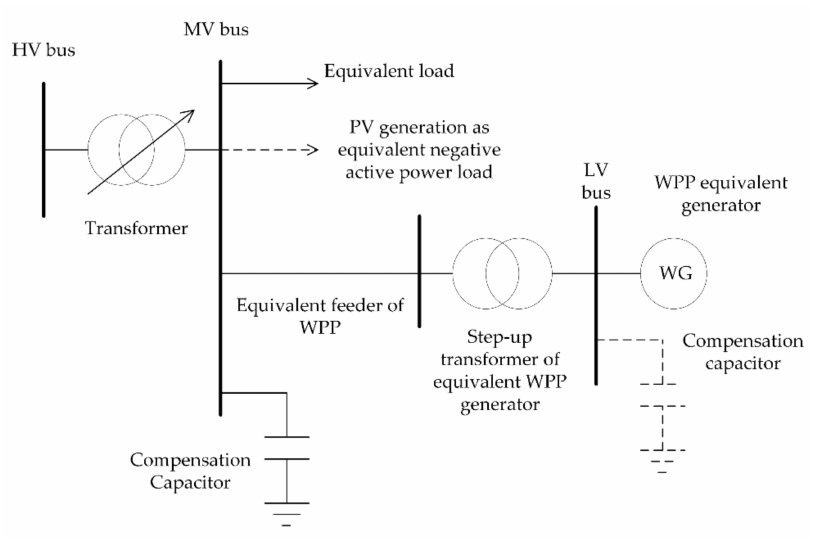
Figure 3. Model of MV network for each HV/MV distribution